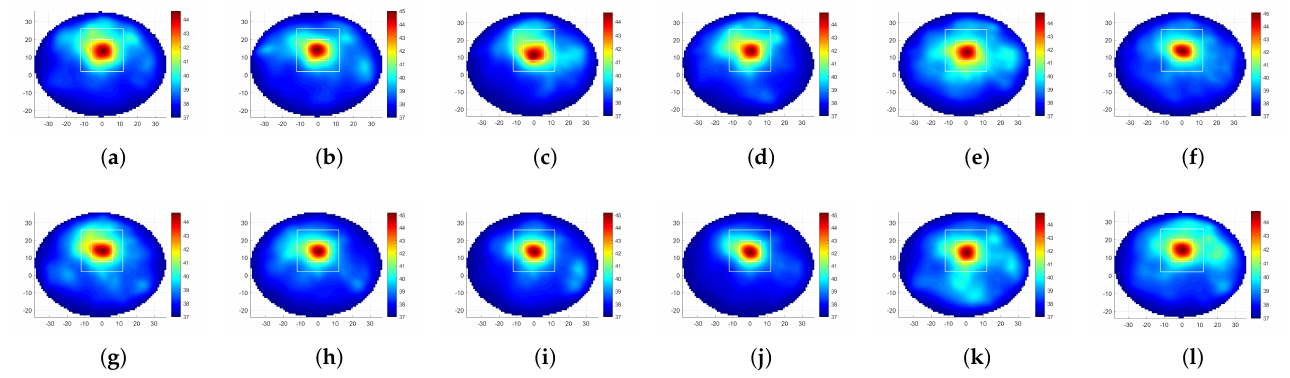
Figure 5. Results of focusing at target-I with the 12-antenna linear MH applicator: ( a – l ) tempera- ture distribution (°C) for θ = 0°, 15°, 30°, 45°, 60°, 75°, 90°, 105°, 120°, 135°, 150°, and 165°. The white squares depict the target (inner) and healthy region (outer) boundaries used for the SAR and temperature metric calculations (the axes are in mm).